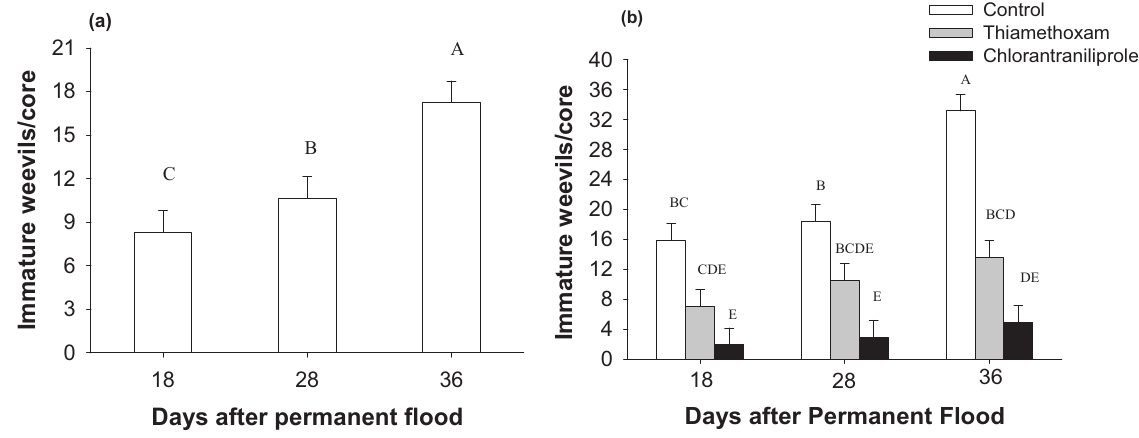
Figure 1. Impact of sampling time on immature weevil densities ( a ) and interaction of sampling time and insecticide treatment on weevil densities ( b ) in the 2009 experiment.